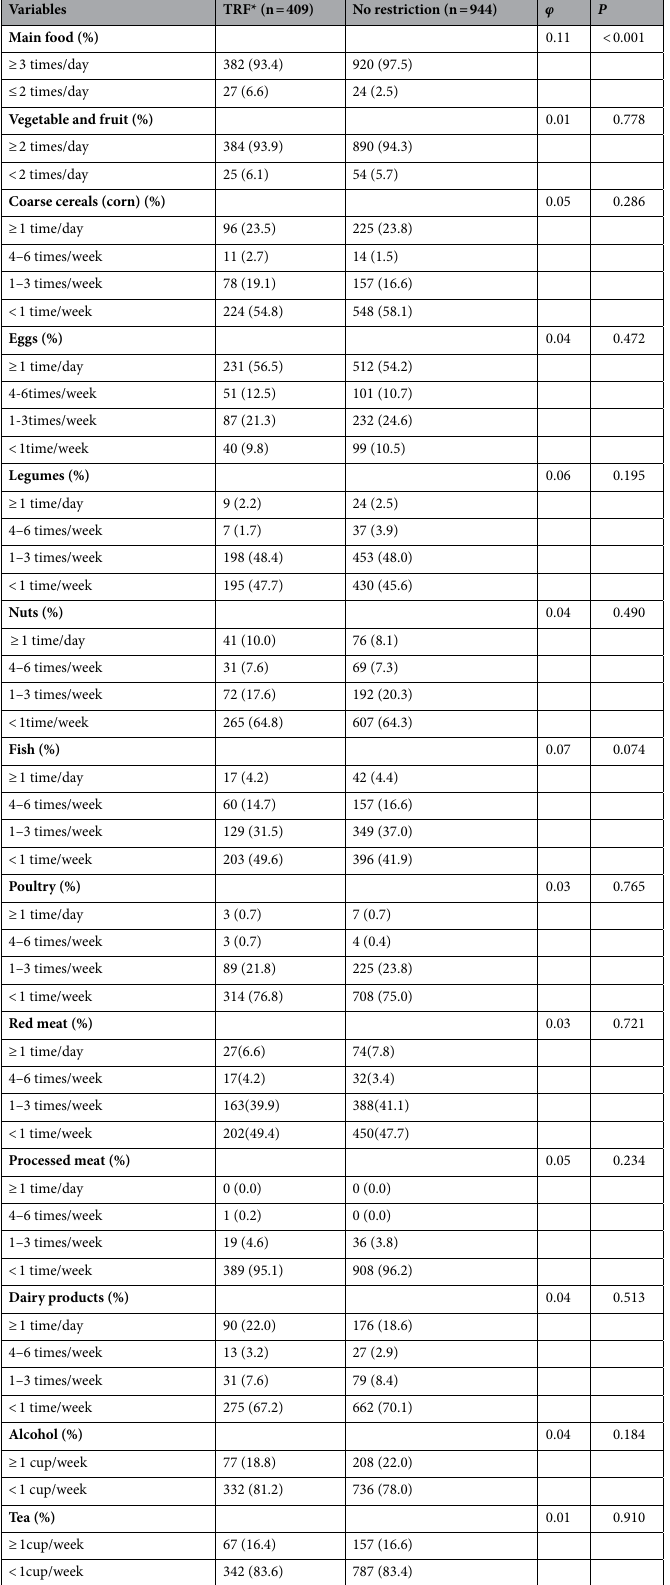
Table 2. The frequency of major food intake according to feeding time window duration (time feeding restricted to 10 h vs. no restriction). TRF Time restricted feeding. *TRF is the control group. △ φ indicates effects sizes in Chi-squared